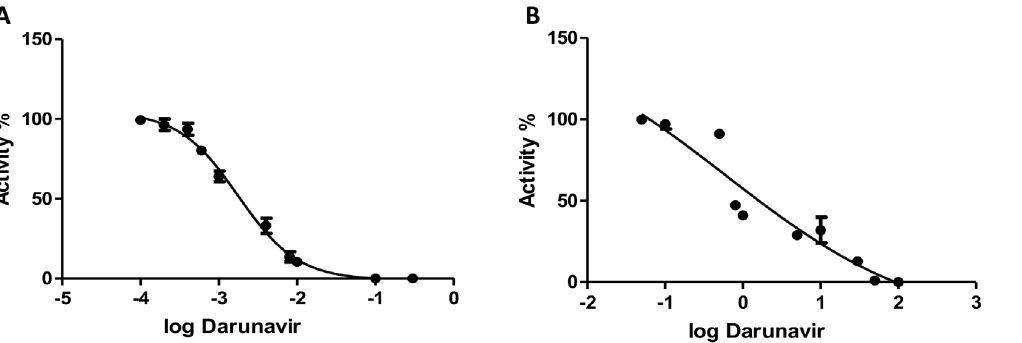
Figure 5. Inhibitory effect of darunavir. A : IC 50 determination in vitro using HPLC. B : IC 50 determination in cell culture. Activity percentage is plotted on the Y axis versus logarithmic transformation of the inhibitor’s concentration ( m